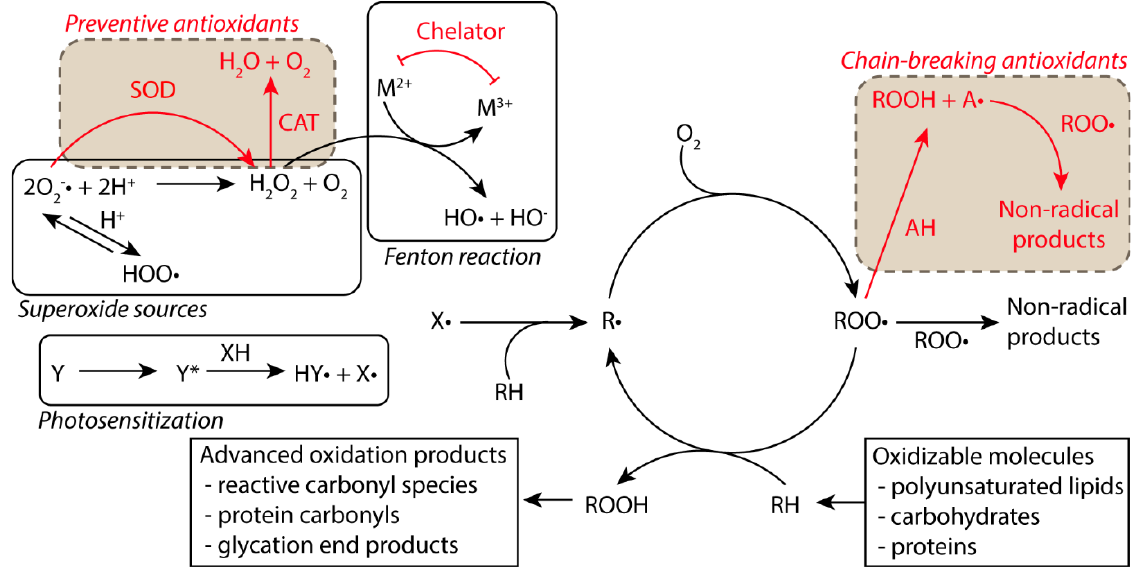
Figure 3: The possible mechanisms of free radical formation and scavenging. The possible free radical scavenging mechanisms (depicted in red) that maintains cellular redox balance. Black shows the radical-chain mechanism that generates alkyl hydroperoxide (ROOH) from autoxidation of a substrate (RH). X• denotes initiator radical, SOD is superoxide dismutase, CAT is catalase and AH denotes chain-breaking